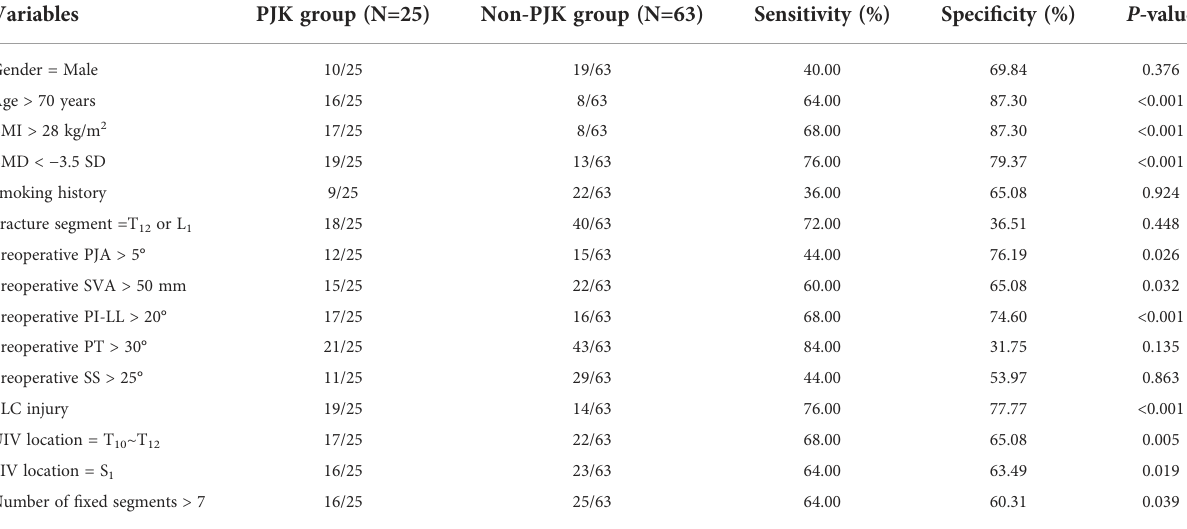
TABLE 1 Univariate analysis of related variables of predicting postoperative proximal junctional kyphosis (PJK).